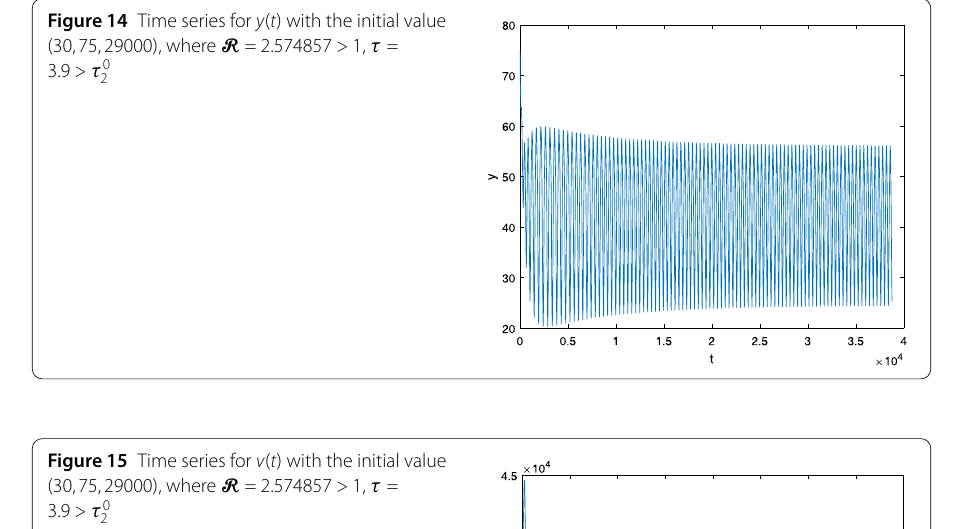
Figure 15 Time series for v ( t ) with the initial value (30,75,29000), where R = 2.574857 > 1, τ =